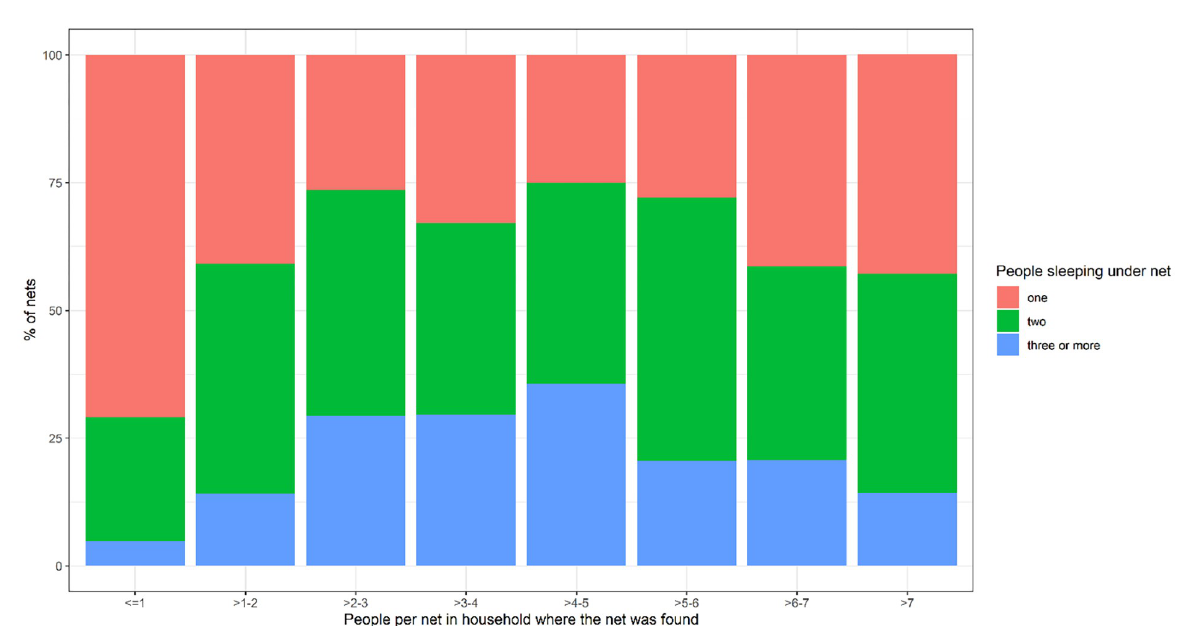
Fig 4. Number of people sleeping under a net according to the number of people per net in the household where the net was found.